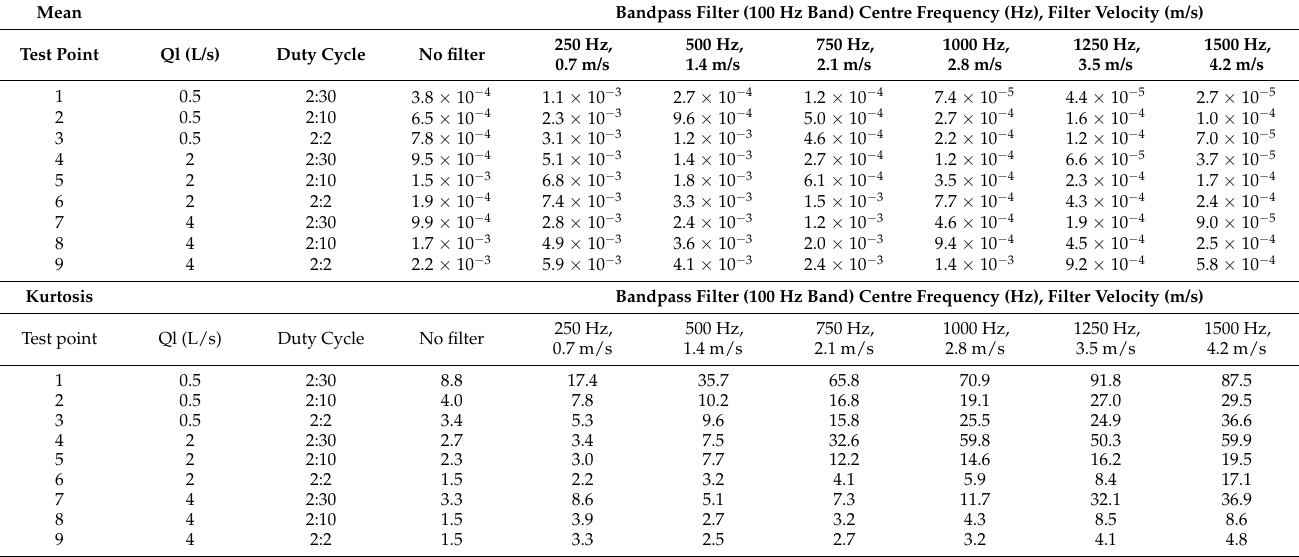
Table 2. The effects of bandpass filters at the different centre